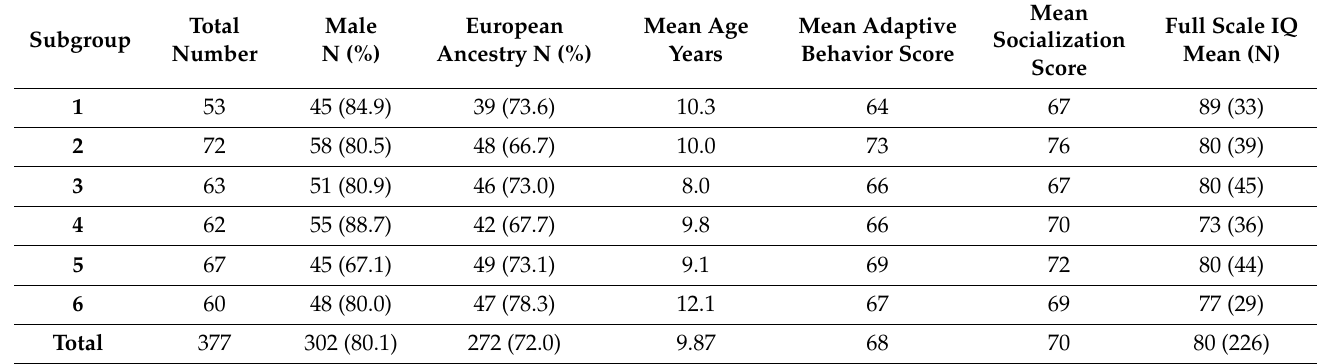
Table 3. Participant features for each subgroup.